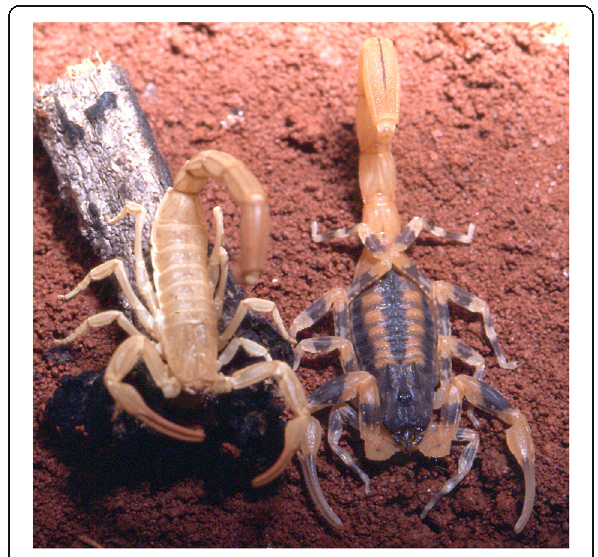
Fig. 17 The exuviation process concluded for the buthid scorpion Tityus fasciolatus from Brazil